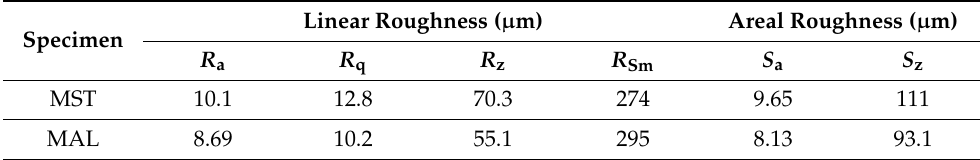
Table 4. Chemical composition of abrasive